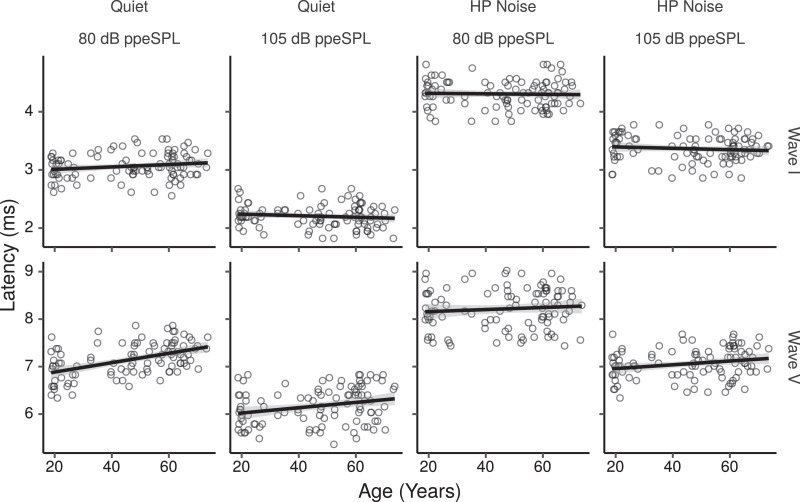
ABR wave I and V latencies by age for the HF-ITPR montage. Each panel shows a least squares line fit of wave latency by age with 95% confidence intervals as a visual aid. The slope for the effect of age estimated by the Bayesian multiple regression model is not the same as that shown in the figure.